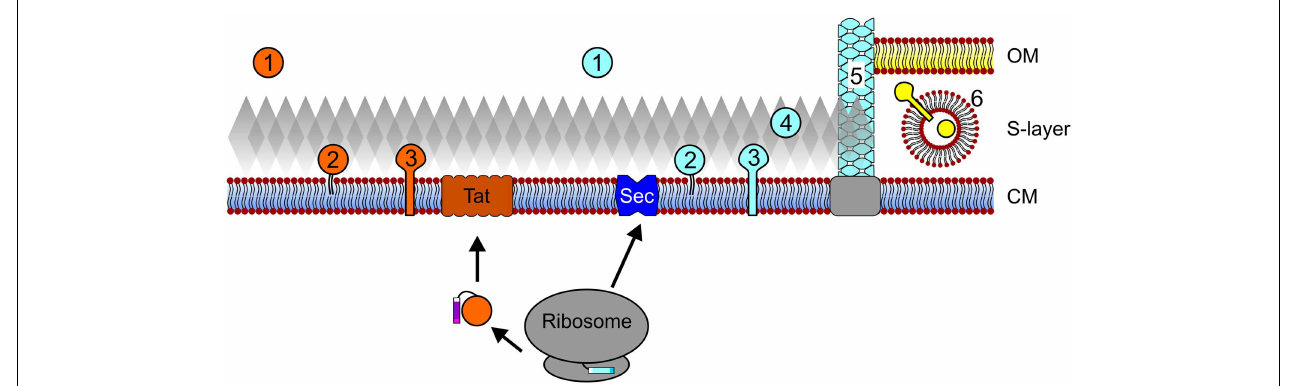
segment (3). In silico data also suggest that Sec substrates may be anchored to the cell wall in an archaeosortase-dependent manner (4) and a number of type IV pilin-like proteins have been shown to assemble into cell appendages (5). In I. hospitalis , an additional outer membrane (OM) is present and periplasmic vesicles (6) are thought to play a role in the trafficking of secreted and outer membrane proteins across the periplasmic space. See text for details. Cell components are not drawn to